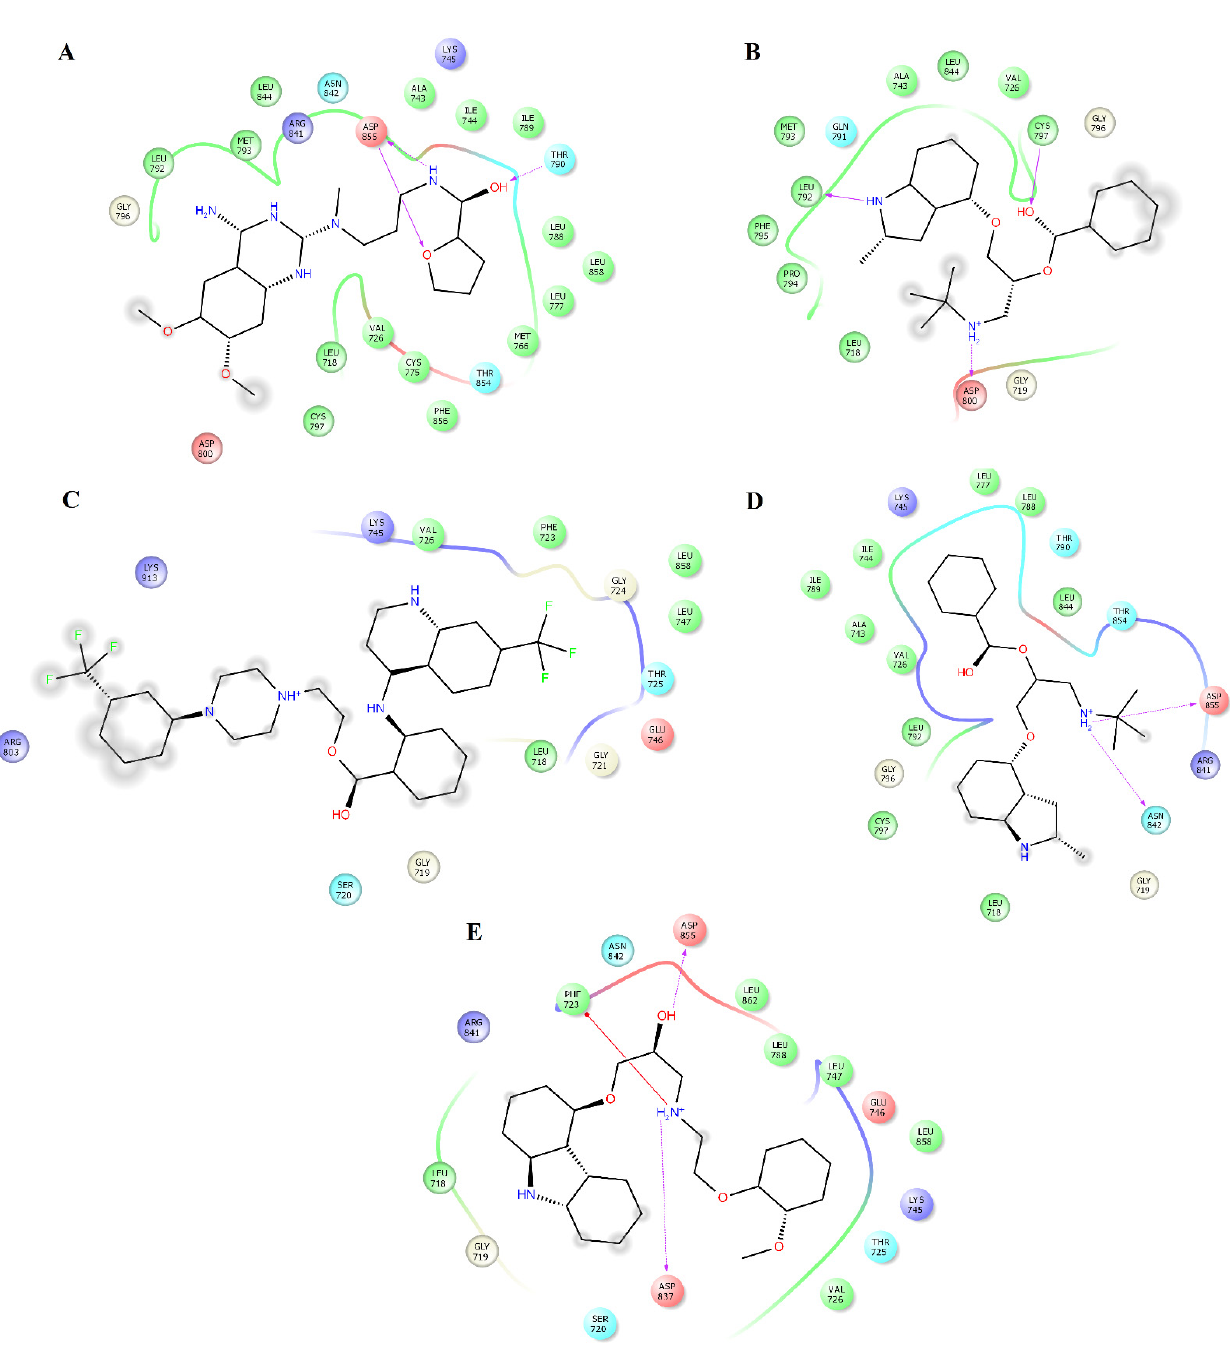
Figure 4. Interactions of the complexes between EGFR and alfuzosin, amodiaquine, antrafenine, bipindolol, and carvedilol. Binding complex for EGFR alfuzosin ( A ); EGFR amodiaquine ( B ); EGFR antrafenine ( C ); EGFR bipindolol ( D ) and EGFR carvedilol ( E ).